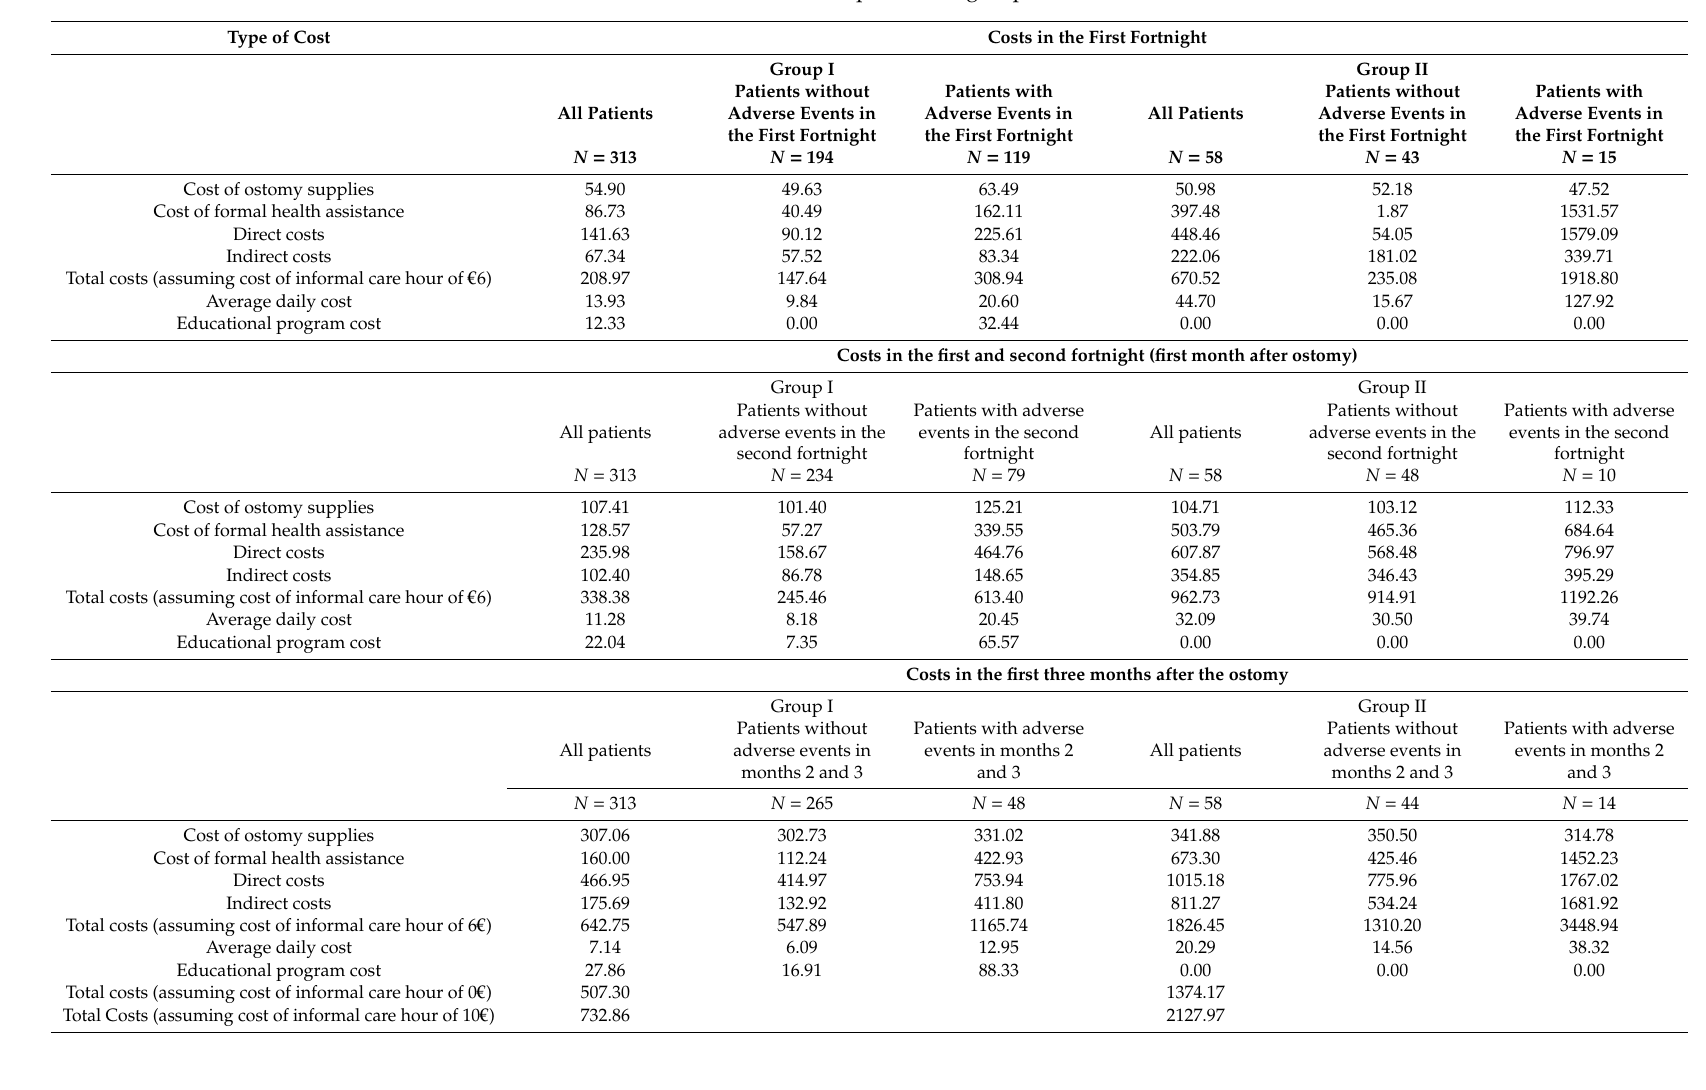
Table 3. Costs of stoma patients in groups I and